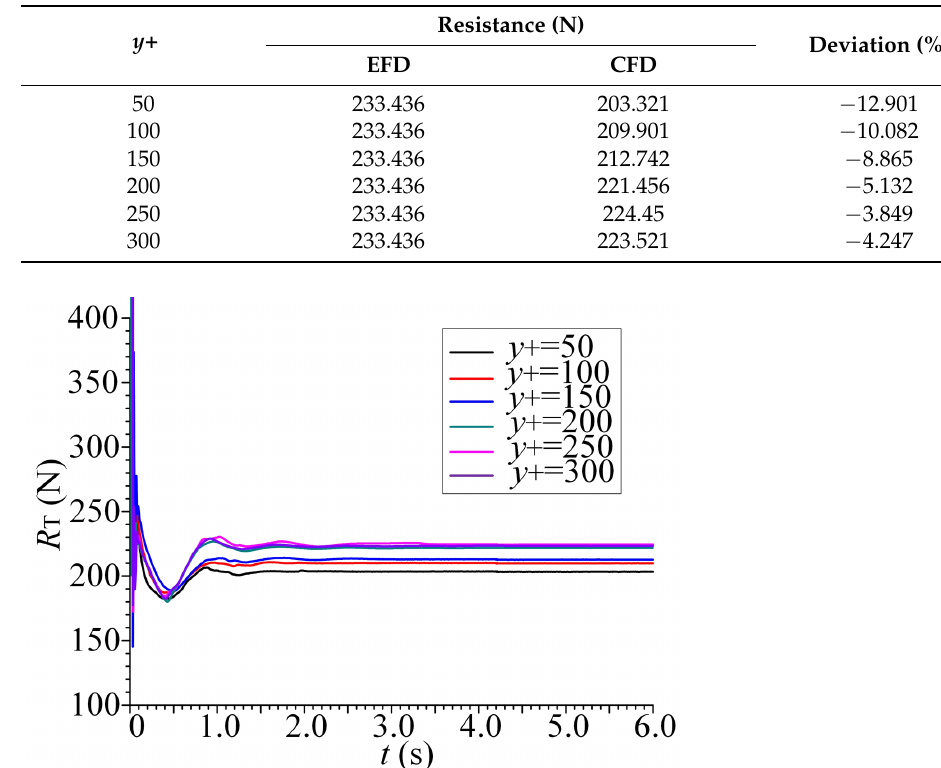
Table 5. Resistance comparisons of the test and numerical results at different y+ values.